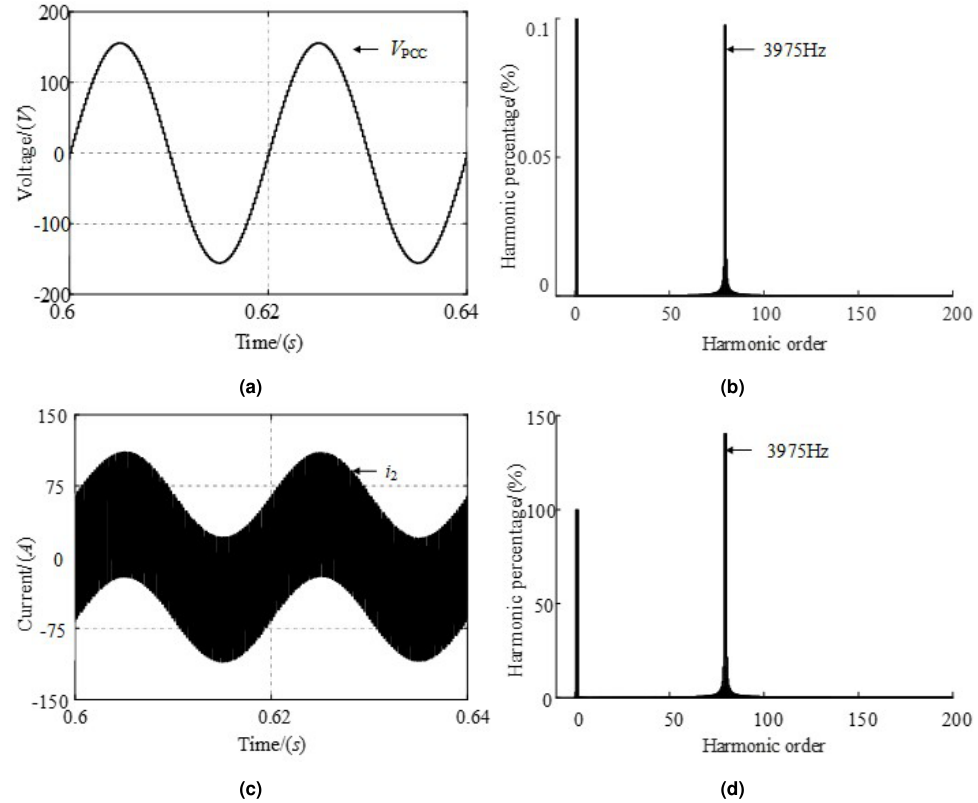
Fig. 8. Simulated waveform of grid-side current. (a) The Simulation Waveform of V PCC . (b) Fast fourier transform analysis of V PCC . (c) The simulation waveform of i 2 . (d) The simulation waveform of i 2 .